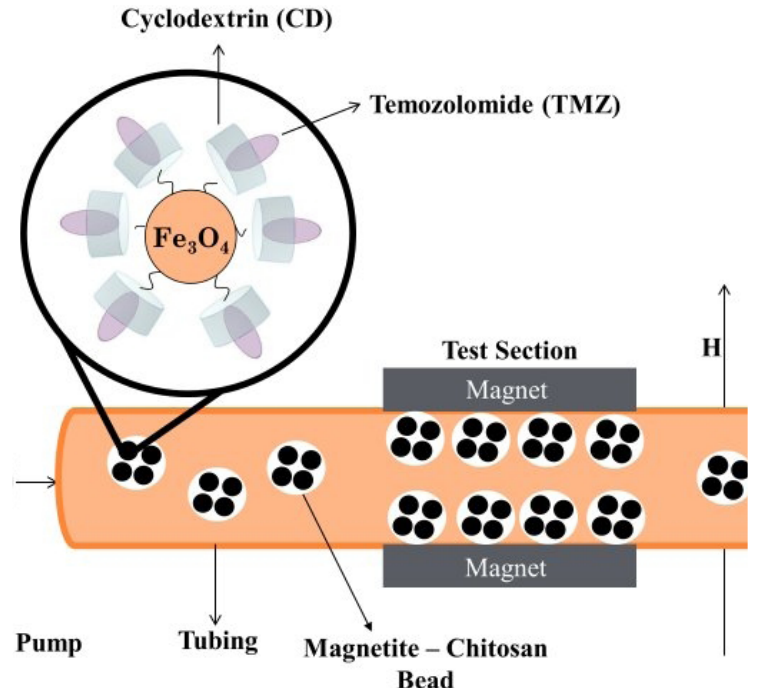
FIGURE 1 - Schematic diagram of the targeting study. TMZ incorporated magnetic nanobeads are circulated via peristaltic pump and collected at the target site by using an external magnetic